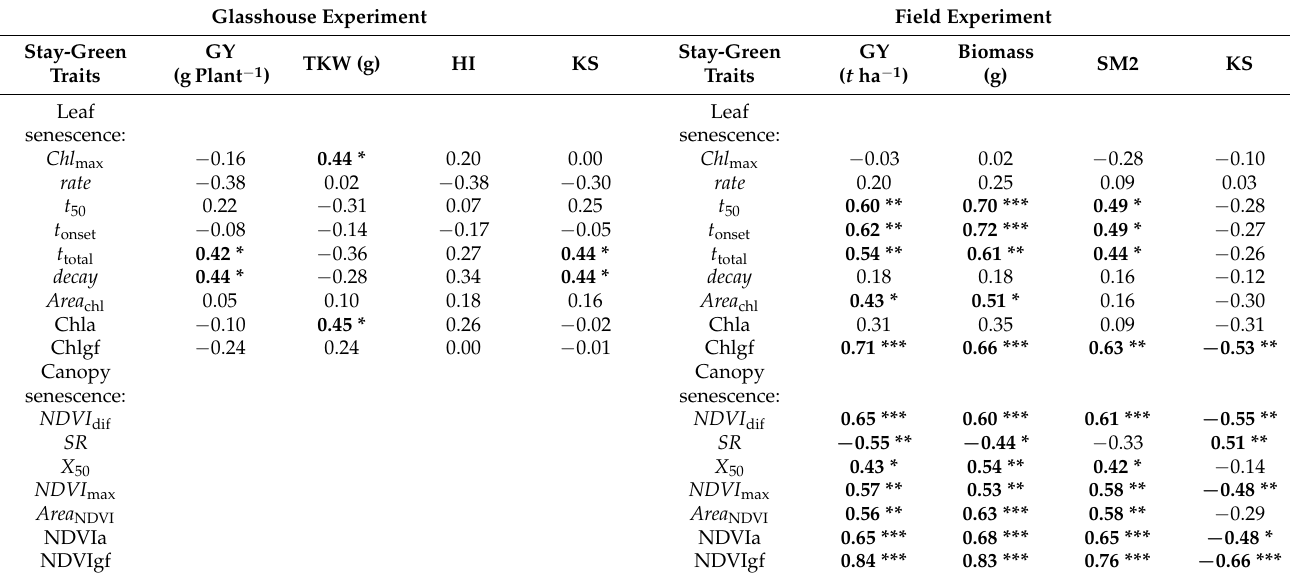
Table 4. Correlations between agronomical and stay-green traits in fourteen selected bread wheat genotypes evaluated in glasshouse and field experiments, grown under well-watered and water- limited